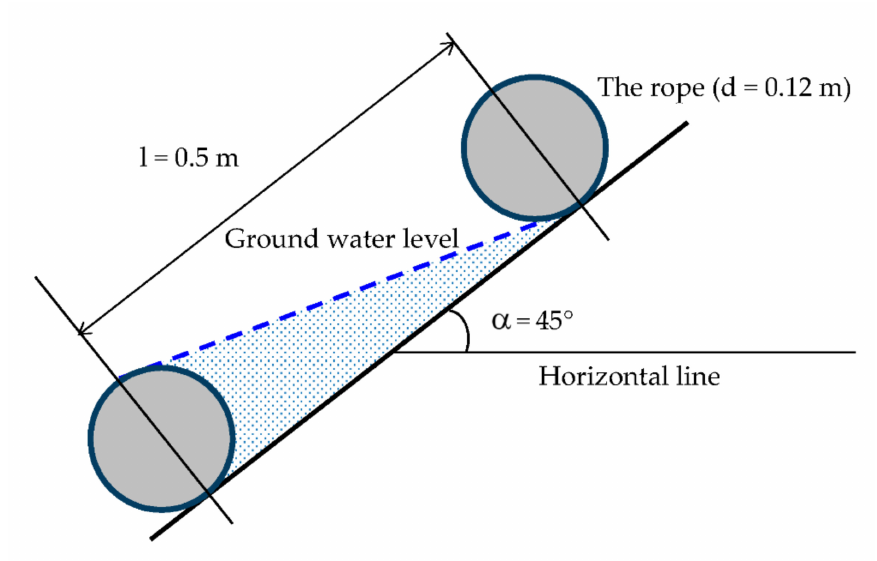
Figure 7. Schema for the calculation of the load acting on the rope at location 4. The load W T acting on rope at location 5 was calculated as the difference between the active force: The tangent component of the soil weight, the force from flowing water, and the passive force (friction and cohesion force on slide surface) using well-known formulas in geotechnical engineering (see Figure 8).